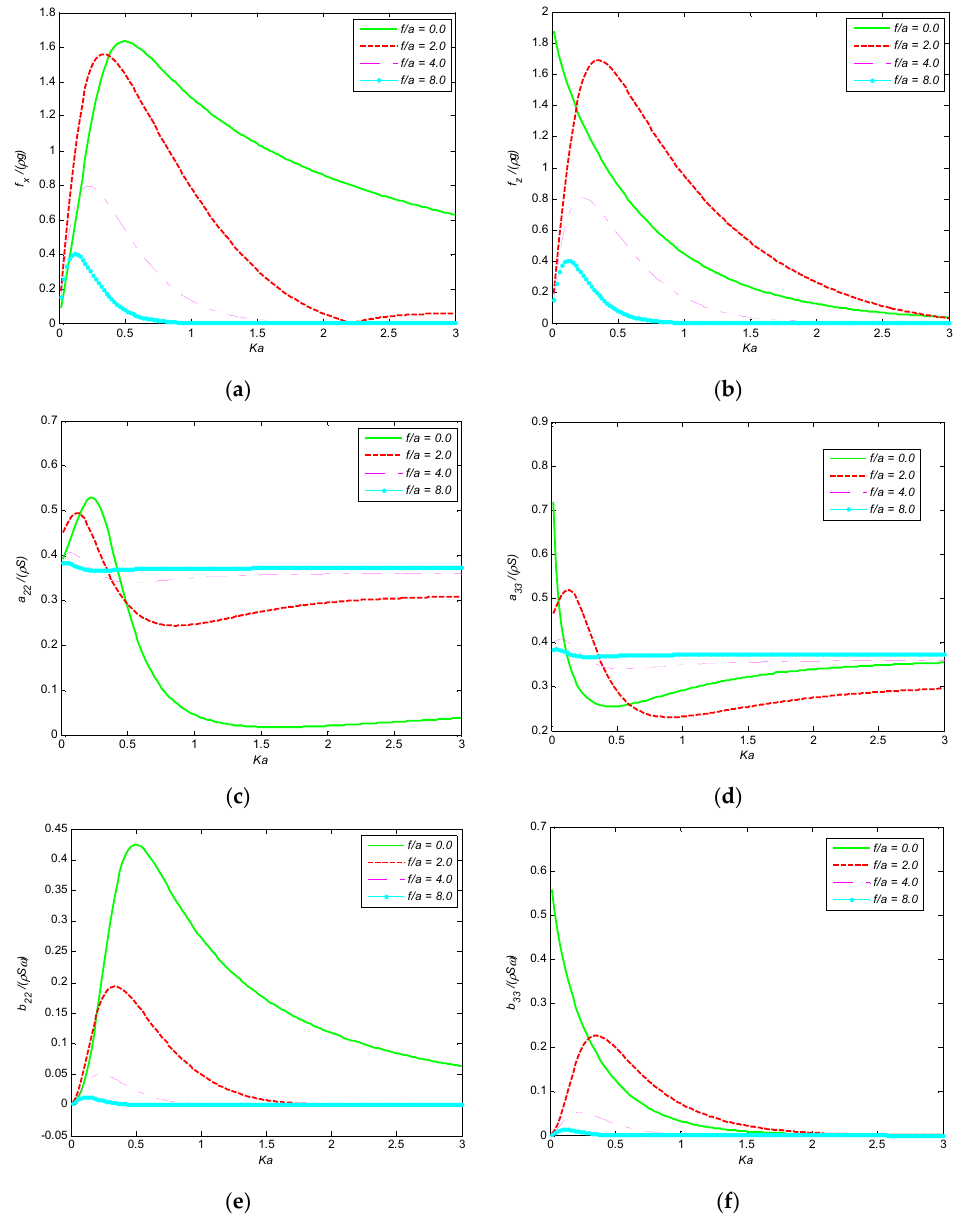
Figure 12. Variation of hydrodynamic characteristics of a floating rectangular cylinder ( f / a = 0.0) and submerged rectangular cylinder for different submergences ( f / a = 2.0, f / a = 4.0 and f / a = 8.0). S represents the cross-section area (note that S of a floating rectangular cylinder is half of a submerged one). For captions of the subplots please refer to Figure 7.